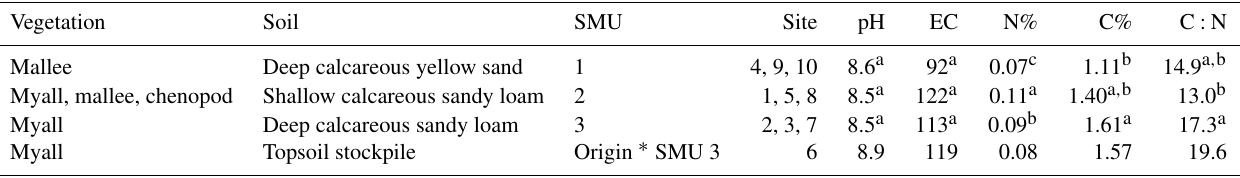
Table 1. Intact biocrust soil physicochemical descriptions for all sites. EC: electrical conductivity in µScm − 1 ; total percentage of nitrogen present (N%), total percentage of carbon present (C%), and carbon-to-nitrogen ratios (C : N) for all sites. Different letters indicate significant differences in columns.